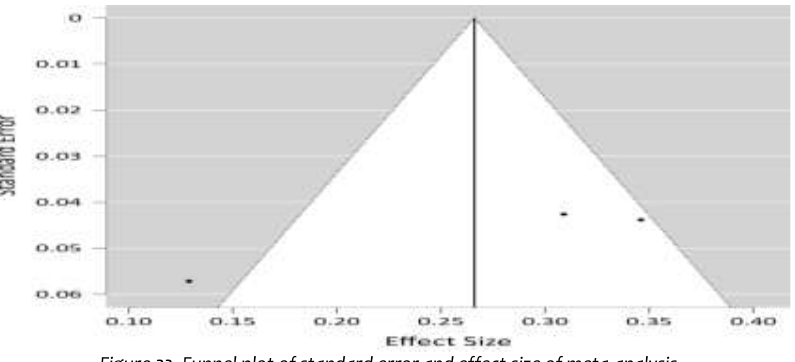
Figure 32. Funnel plot of standard error and effect size of meta-analysis of Motivation for stimulation and L2 test